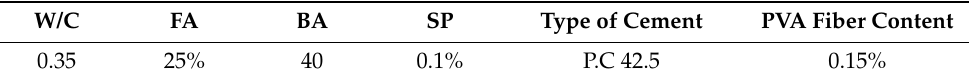
Table 8. Optimal mix ratio of foam concrete based on engineering properties. W/C FA BA SP Type of Cement PVA Fiber Content 0.35 25% 40 0.1% P.C 42.5 0.15%